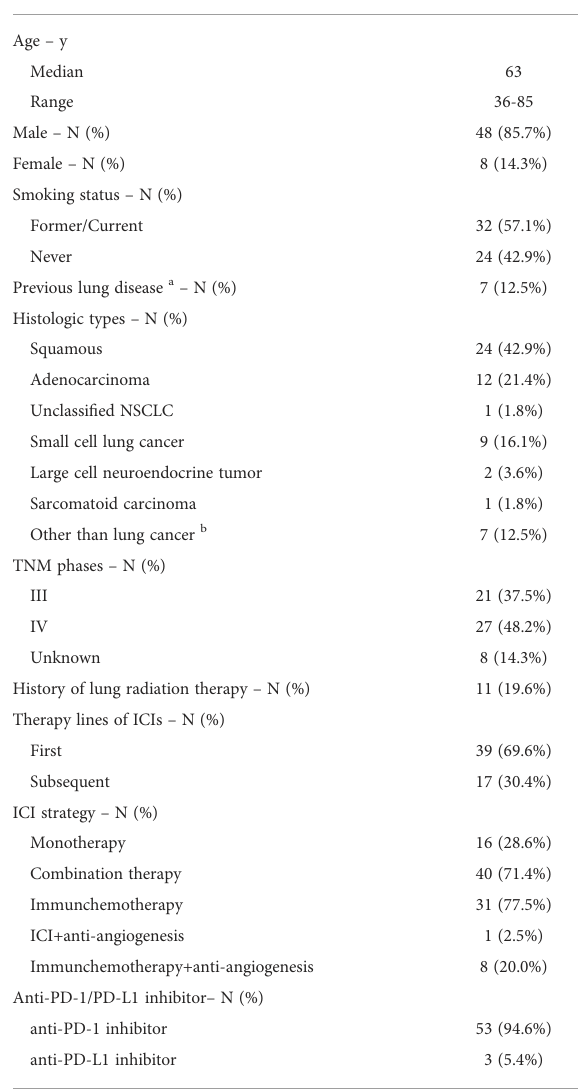
TABLE 1 The baseline information of patients before diagnosis with checkpoint inhibitor-related pneumonitis (CIP).